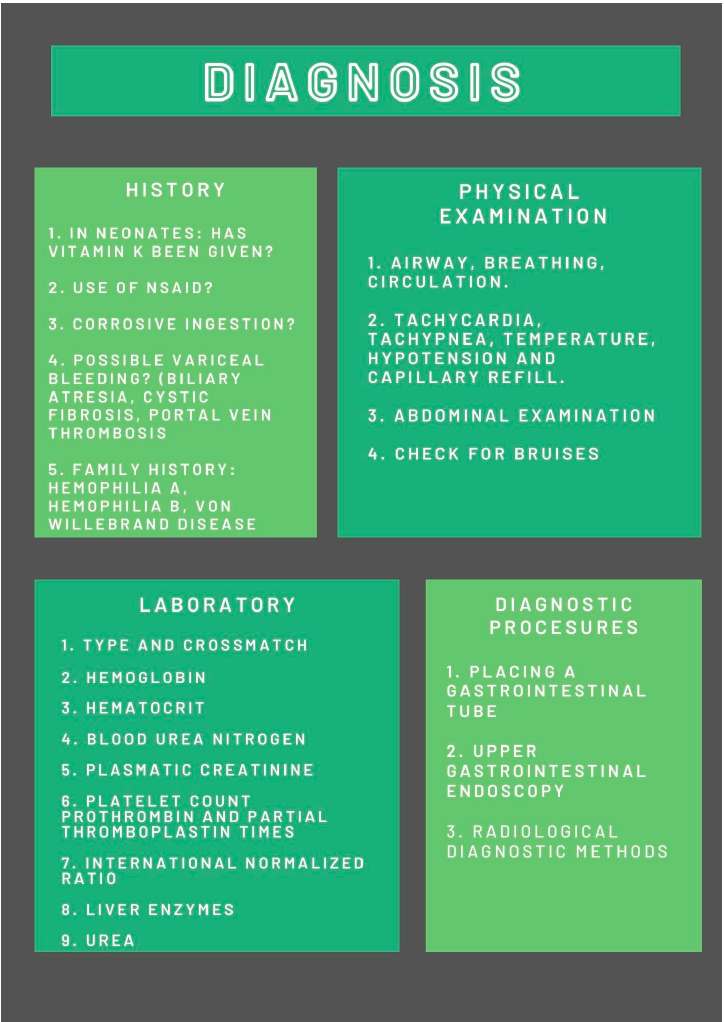
Figure 1. Diagnosis of UGB.